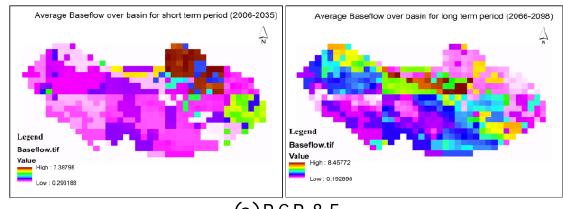
Figure 13. Spatial change in ET under each scenario